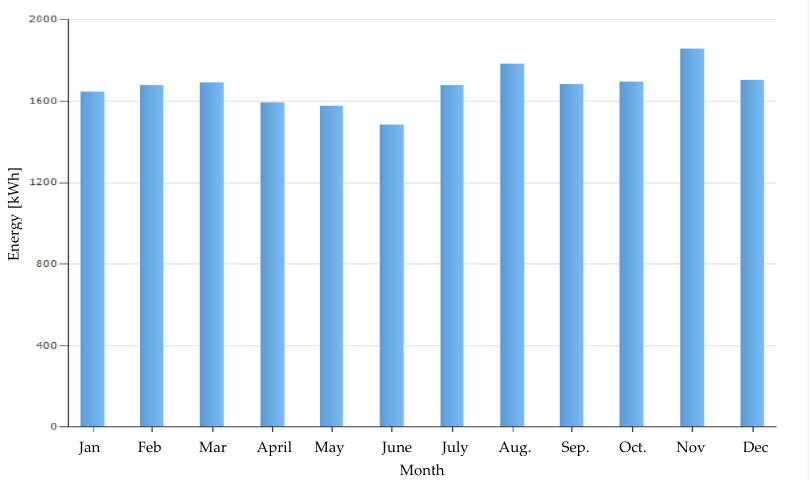
Figure 23. Monthly energy production of PV solar generation.